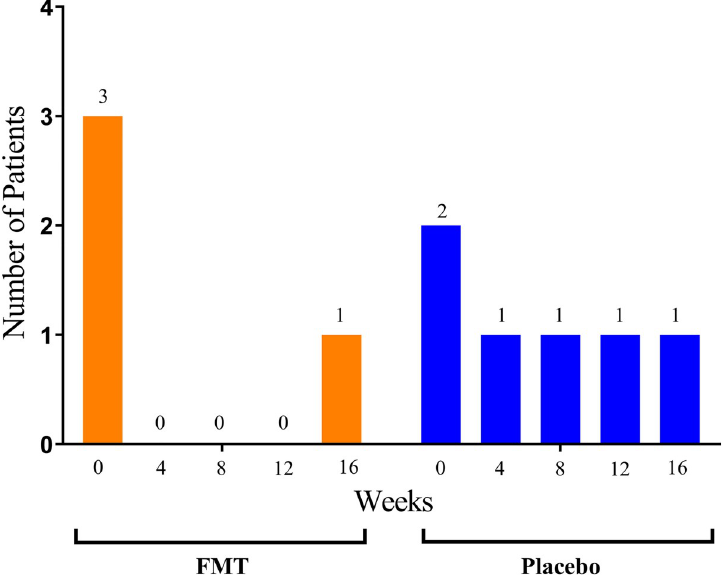
Fig 3. Changes in patient reported fecal incontinence. Patient reported fecal incontinence was registered at week 0, 4, 8, 12 and 16 as an exploratory endpoint. Three patients in the FMT group (orange) had fecal incontinence at week 0, with restoration of incontinence at week 4. Two patients in the placebo group (blue) had fecal incontinence at week 0, with restoration of incontinence within week 4 in one patient.